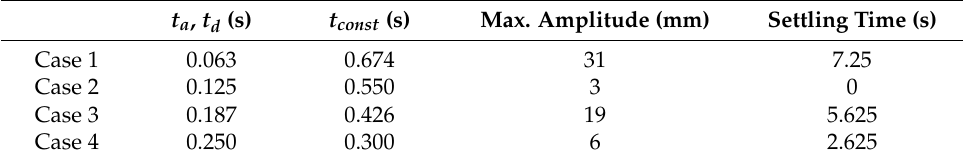
Figure 20. Position deviations at target: ( a ) when 𝑡 (cid:3028) = 0.063 ; ( b ) when 𝑡 (cid:3028) = 0.250 . Table 5. Experimental results of maximum amplitude and settling time when moving 425 mm over 0.8